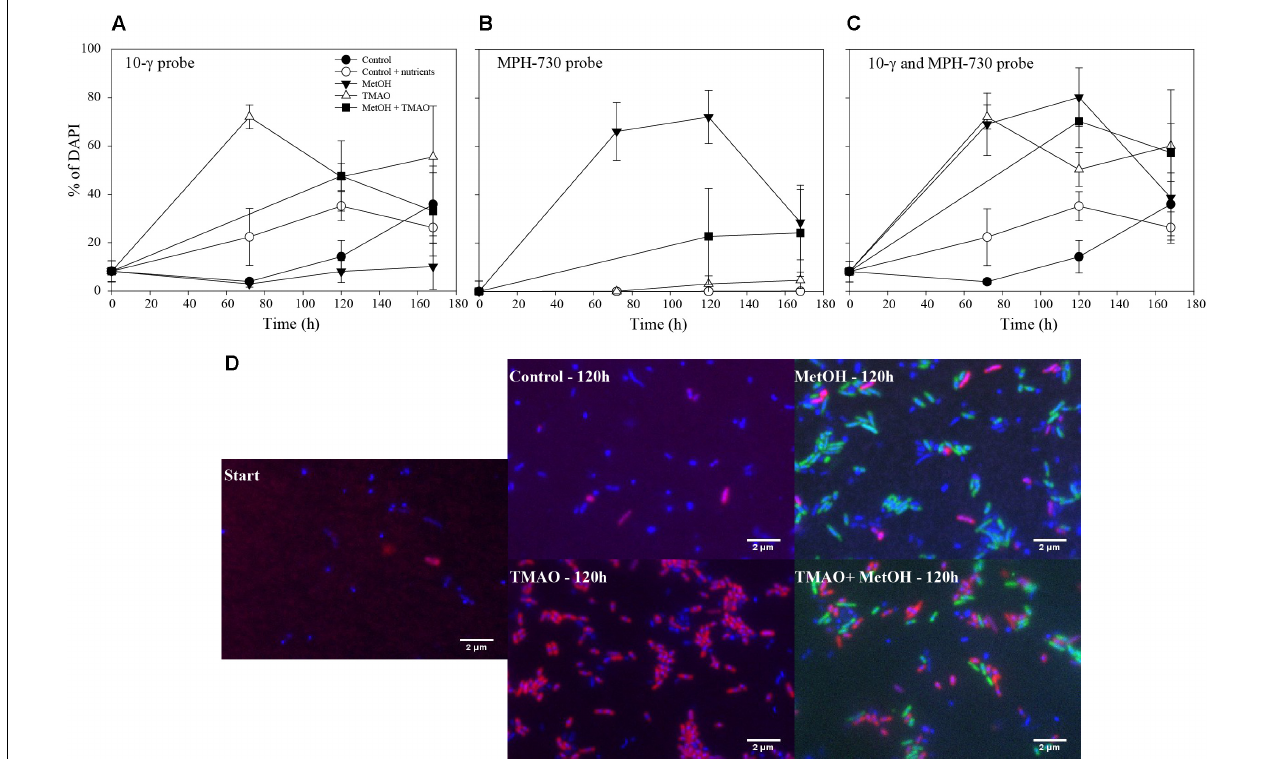
FIGURE 7 | Percentage of hybridization over time for the 10- γ probe (A) , MPH-730 probe (B) and the sum of both probes (C) . Merged epifluorescence images of fluorescence in situ hybridization for the 10- γ probe (red) accounting for γ - and β -Proteobacterial methylotrophs with the RumP pathway, MPH-730 probes (green) accounting for Methylophaga spp. bacteria and DAPI-stained organisms (blue) (D)